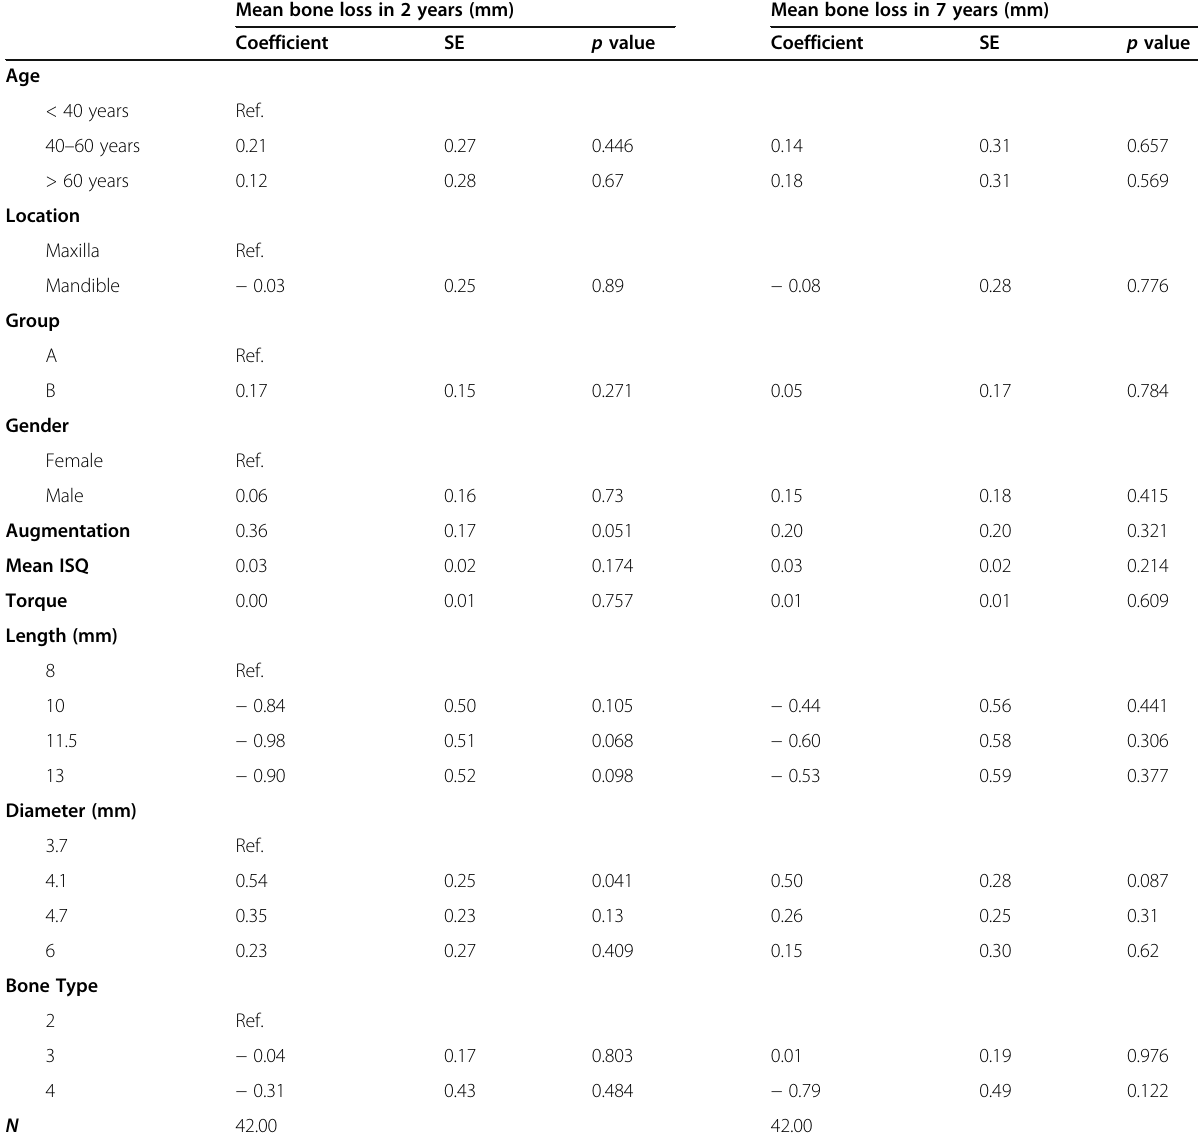
Table 9 Multivariate regression analysis on bone loss